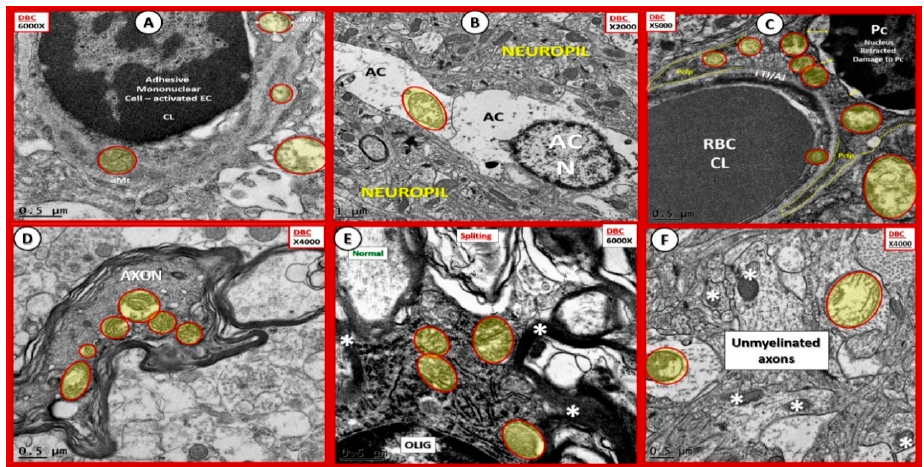
Figure 5. Aberrant mitochondria in endothelial cells, pericytes, and foot processes, astrocytes, oligodendrocytes, myelinated and unmyelinated neurons. Panels ( A – F ) demonstrate that aberrant mitochondria (aMt) were found to be present in multiple cells in addition to activated microglia cells (aMGCs). The aMt are pseudo-colored in each of these panels (yellow outlined in red lines) in order to allow their rapid recognition. Panels depict the aMt characterized by swollen mitochondria (Mt), loss of electron-dense Mt matrix and crista. Panel ( A ) illustrates the aMt within the endothelial cells and surrounding aMGC. Panel ( B ) depicts aMt within AC cytoplasm. Panel ( C ) demonstrates aMt in pericytes and foot processes (Pc and Pcfp). Panel ( D ) depicts aMt in a dysmyelinated neuronal axon. Panel ( E ) depicts aMt within an oligodendrocyte cytoplasm and Panel ( F ) illustrates aMt in an AC to the left and an unmyelinated axon on the right within the neuropil. Scale bars = 0.5 µm in all images except for panel ( B ) which has a scale bar = 1 µm [2].